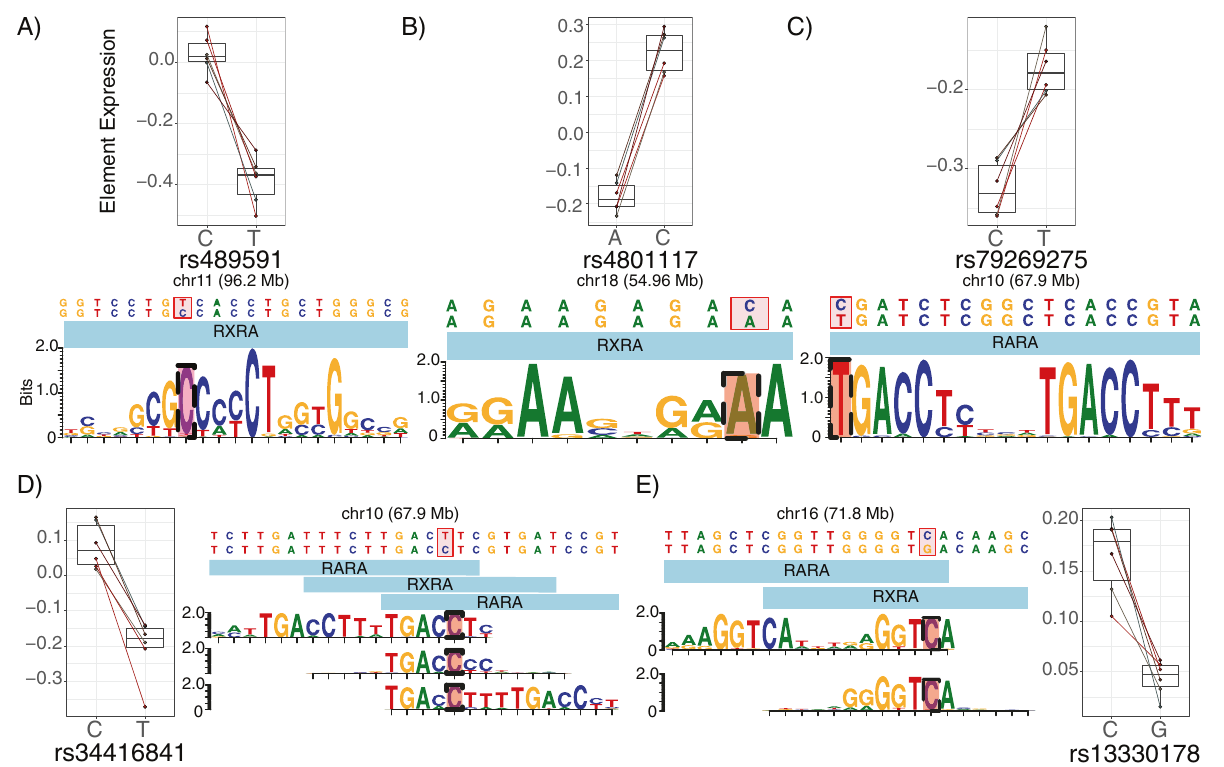
Fig. 3 MPRA signal at SNPs disrupting putative retinoid TF motifs. The fi ve functional SNPs driving enrichment signals for retinoid TF motif perturbations are shown, along with the MPRA results for each variant. Each motif diagram shows only distinct position-weight matrices (PWMs) (motifbreakR uses a large meta-collection of motifs, which were often identical or nearly identical across retinoid TFs; such redundant motifs are not shown). Among functional-SNP enriched retinoid TFs, A rs489591 and B rs4801117 exclusively perturb RXRA motifs. C rs79269275 perturbs an RARA (or RARB, identical but not shown) motif. D rs34416841 alters several similar retinoid motifs across multiple positions and TFs. Not shown: near-identical motifs for RARB along the same sequence as the 5 ′ RARA motif; near-identical RXRB and RARB motifs along the same sequence as the center RXRA motif; and a near-identical RARB motif along the same sequence as the 3 ′ RARA motif. E rs13330178 disrupts an RARA or RXRA binding site. Given that RXRA and RARs are known to heterodimerize, it is possible that this SNP disrupts the RXRA component of such a heteromer ’ s binding